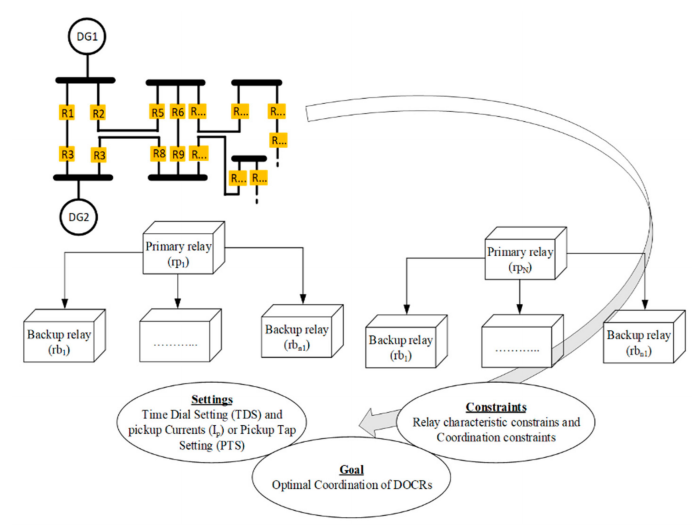
Figure 1. Schematic outline for DOCR coordination in an electrical power